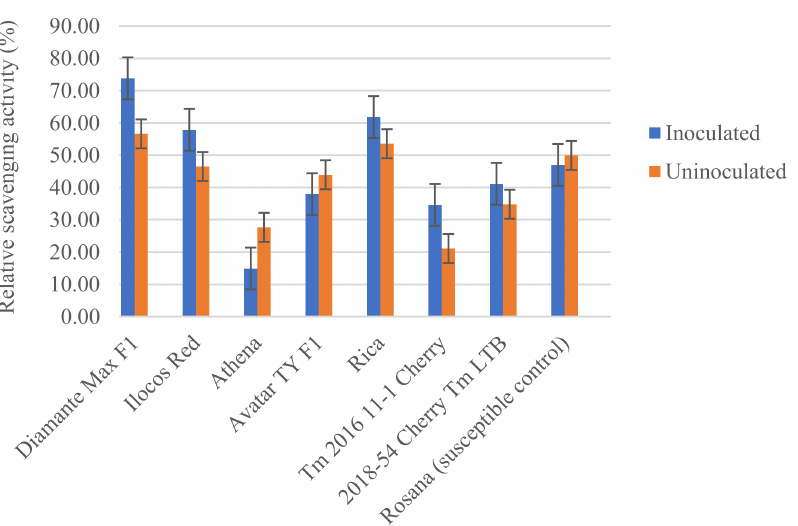
Figure 4. Average relative scavenging activity of extracts from different tomato varieties tested against Meloidogyne incognita . Error bars represent standard error of the